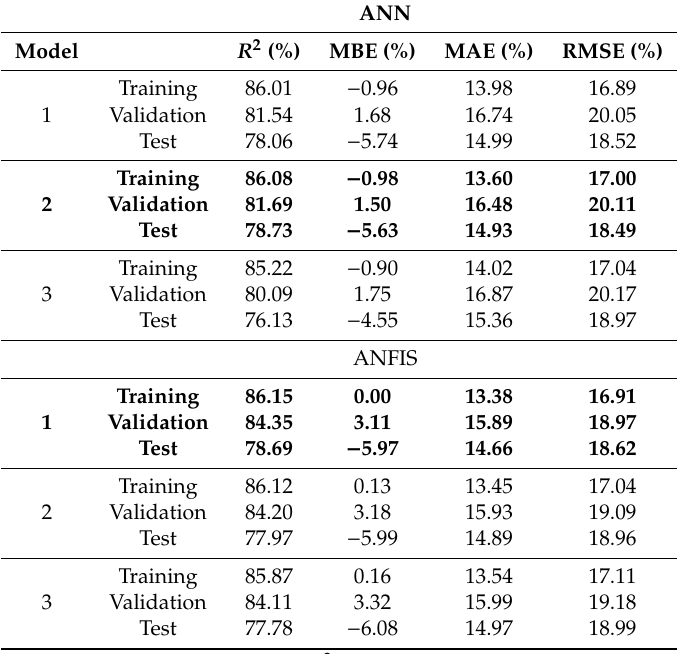
Table 7. Training, validation, and test statistics for the estimation of total height using ANN and ANFIS models.